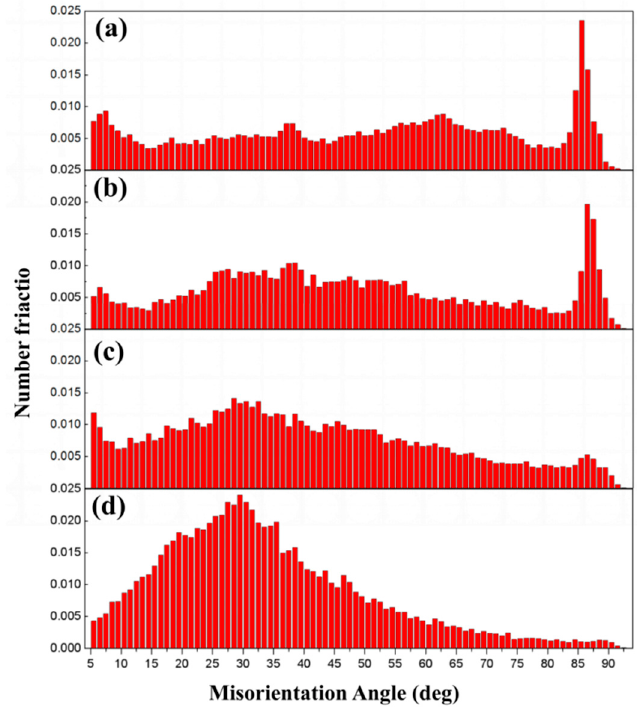
Figure 2. Number fraction of the misorientation in AZ31 alloys HSRMFed to different accumulated strain with pass strains of Δ ε = 0.22 ( a ) 0.22, ( b ) 0.44, ( c ) 0.88 and ( d ) 1.32.